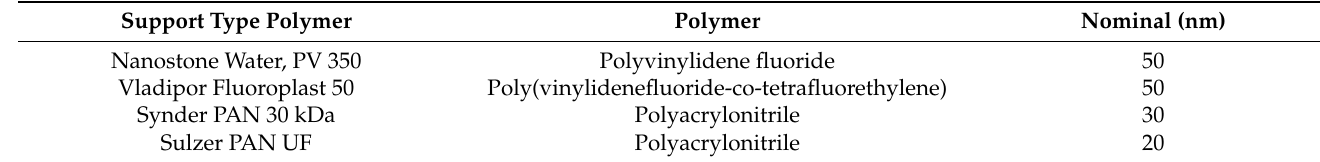
Table 1. Porous support membranes used for the TFC